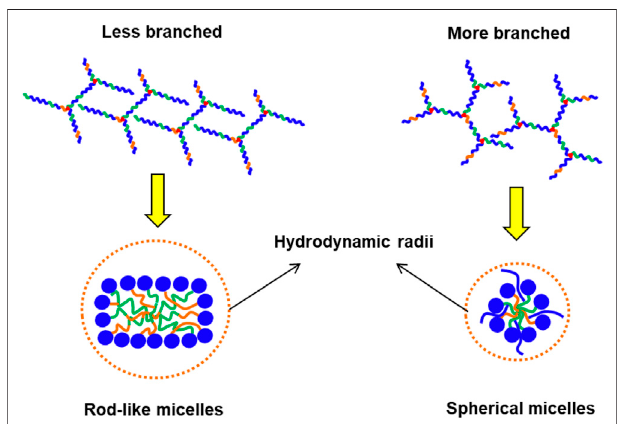
FIGURE3| Schematiccomparisonbetweenthemicellesformedbyless branched and more branched EPCG copolymers with the former being plausibly more rod-like with larger hydrodynamic radii and the latter being spherical with smaller hydrodynamic radii.